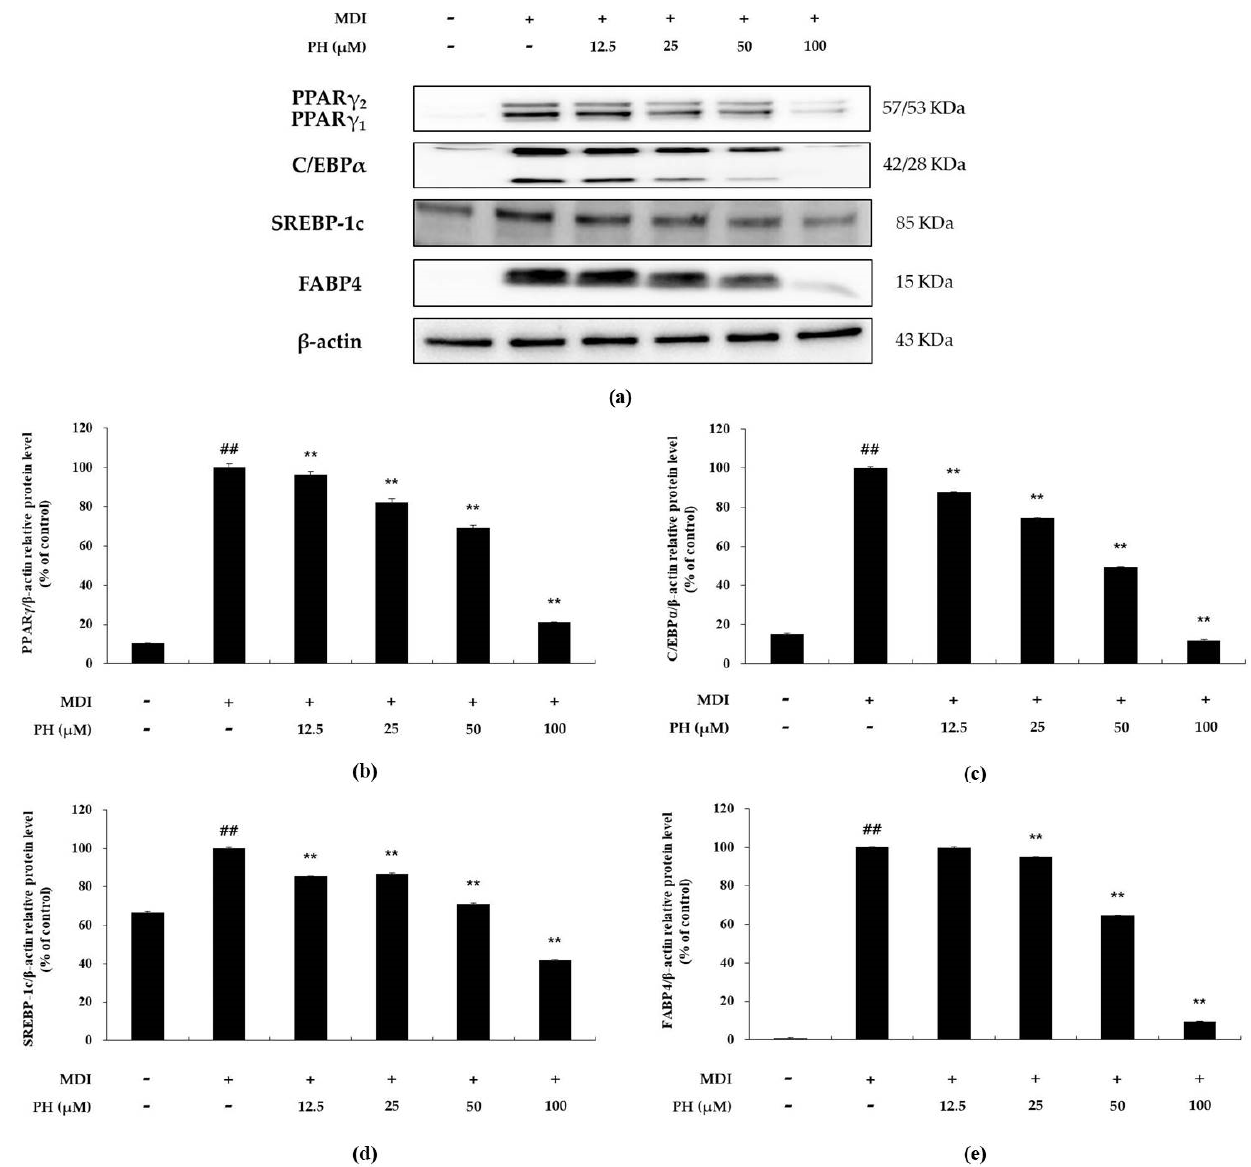
Figure 3. Effect of PH on the expression of adipogenesis-related transcription factors. Adipocyte differentiation was induced in post-confluent cells using MDI differentiation medium and treated with the indicated concentrations of PH for 6 days. ( a ) Western blot of PPAR γ , C/EBP α , SREBP-1c, FABP4, and β -actin in 3T3-L1 adipocytes. The relative protein levels of ( b ) PPAR γ / β -actin, ( c ) C/EBP α / β -actin, ( d ) SREBP-1c/ β -actin, and ( e ) FABP4/ β -actin are presented as the mean ± standard deviation of three independent measurements using the ImageJ program. The results in the relative protein levels are expressed as percentages relative to the control group treated with MDI alone. ** p < 0.01 indicates significant differences versus the MDI-only control. ## p < 0.01 indicates significant differences versus an untreated control.